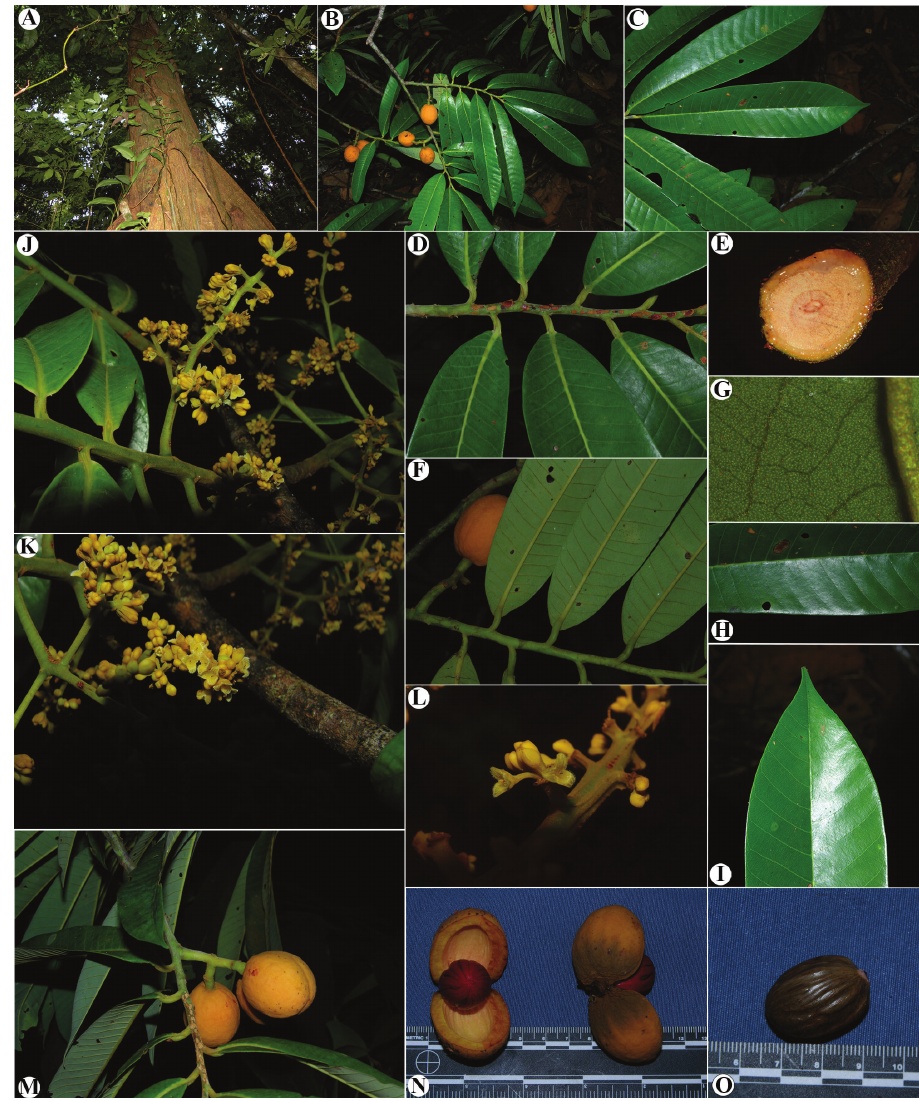
Figure 25. Virola cf. nobilis from the Osa Peninsula, Costa Rica A trunk B branch with fruits C leaf blades on adaxial surface D twig, petiole and leaf base on adaxial surface E exudate on a twig F, G leaf blades on abaxial surface and trichomes ( G ). H Leaf margin I leaf apex J staminate inflorescences K detail of staminate inflorescences L detail of staminate flower M branch with fruits N fruits O seed. Photos by Reinaldo